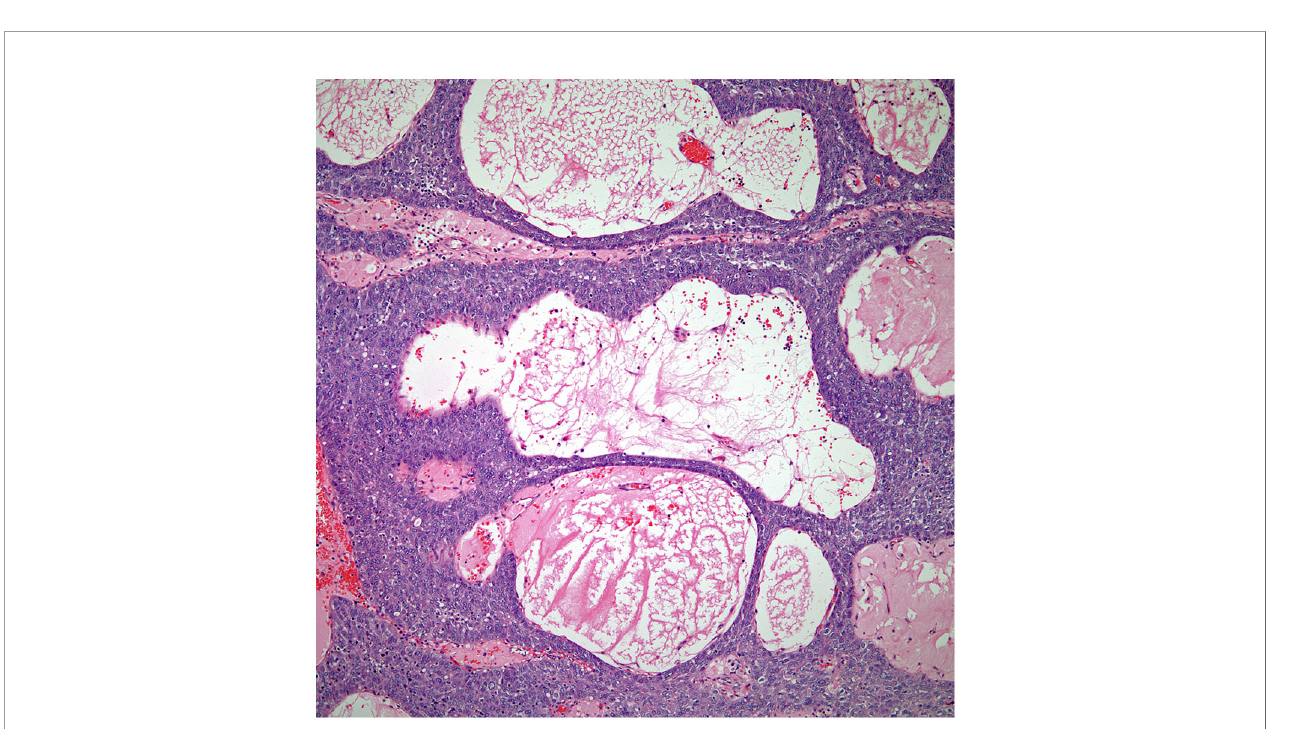
FIGURE 8 | Cystic basaloid carcinoma of the thymus.